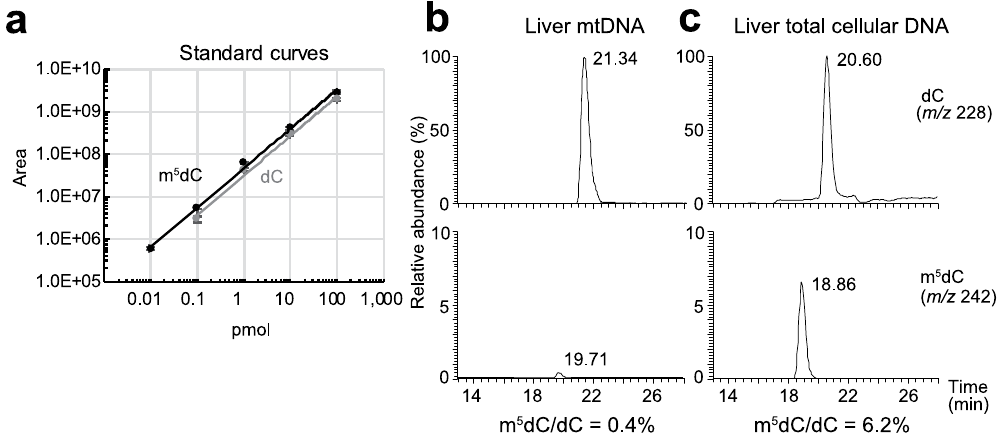
Figure 6. Mass spectrometric nucleoside analysis of mtDNA. ( a ) Standard curves of deoxycytidine (dC; grey line) and 5-methyldeoxycytidine (m 5 dC; black line) produced with serially diluted authentic chemicals; X and Y axes show amounts of authentic mononucleosides applied and peak areas of corresponding extracted mass chromatograms, respectively. Authentic samples were analysed three times and the means are plotted with SD. ( b,c ) Analyses of dC and m 5 dC in mtDNA ( b ) and total cellular DNA ( c ) from liver tissues. Top and bottom panels show extracted mass chromatograms for proton adducts of dC ( m/z 228) and m 5 dC ( m/z 242), respectively. Numbers near the peaks indicate retention times. Due to low abundance of mtDNA, results from total cellular DNA effectively represent the state of nuclear DNA. Two independent preparations were analysed once